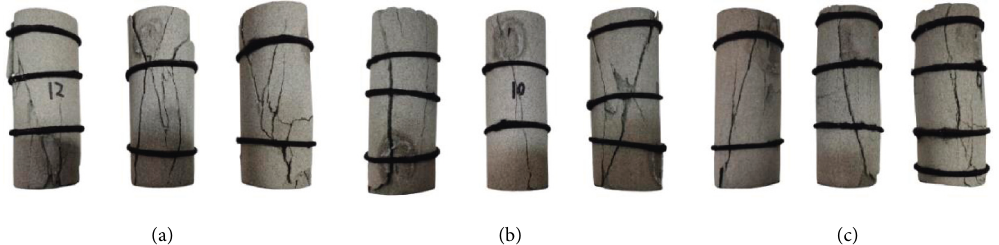
Figure 11: Uniaxial compression of green sandstone after freeze-thaw cycles. (a) Group A loading results. (b) Group B loading results. (c) Group C loading results.